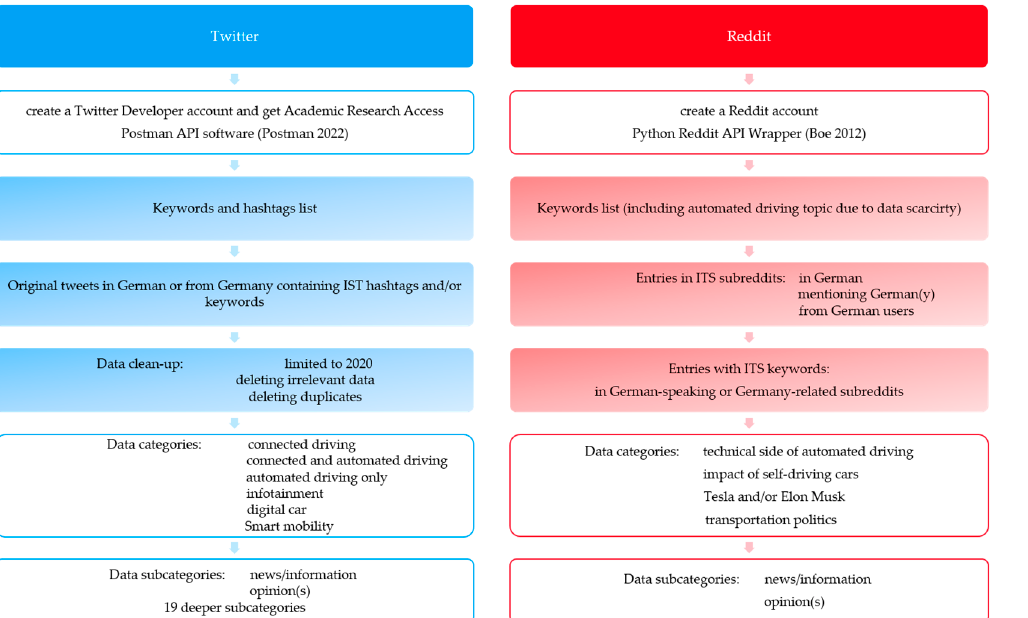
Table 1. Keywords and/or hashtags related to ITS topics. Reddit and Twitter